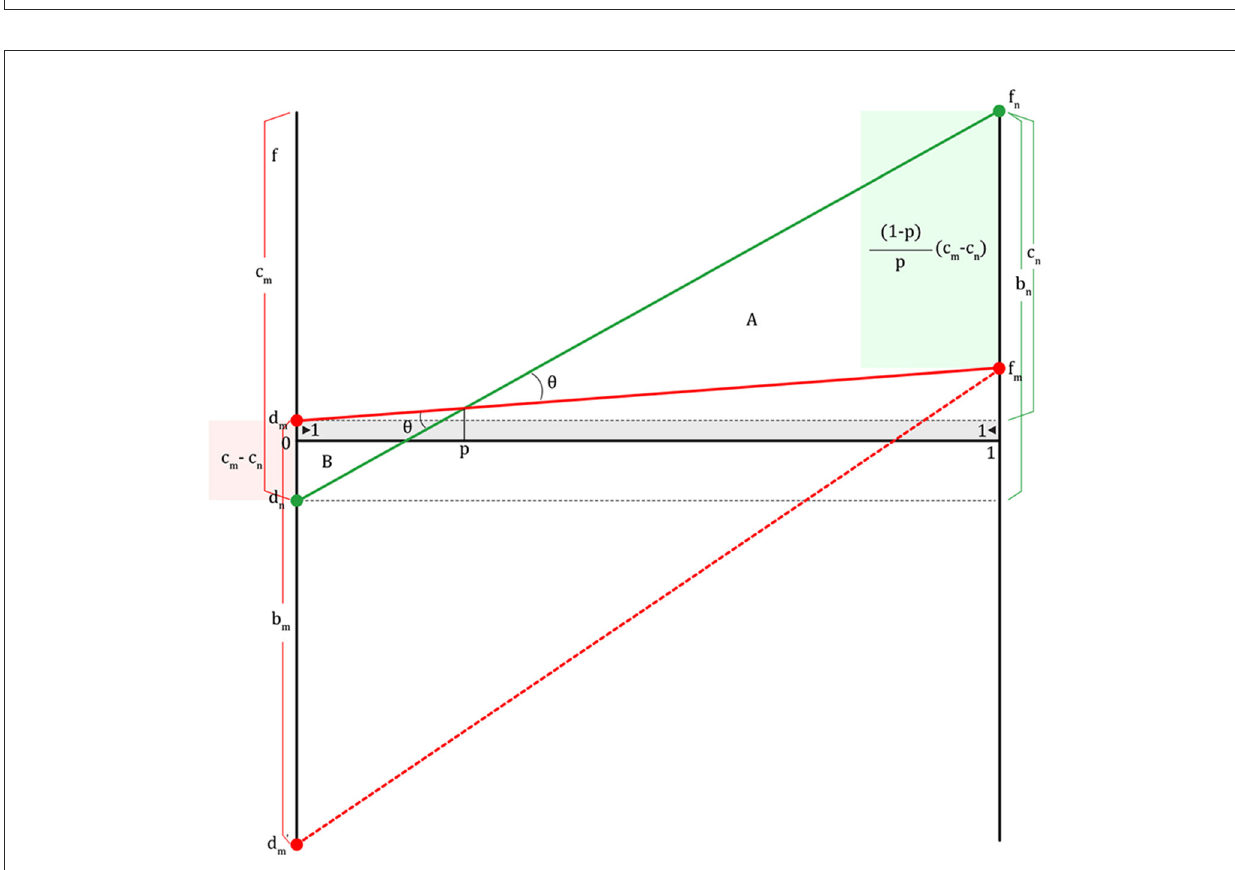
FIGURE4 The combination of reciprocal altruism and the game between a migraineur and a non-migraineur (c m , cost of migraineur; b m , benefit of migraineur; c n , cost of non-migraineur; b n , benefit of non-migraineur; d m , fitness of migraineur when a migraineur meets a non-migraineur; d m ≥ 1, p, population proportion of migraineurs).